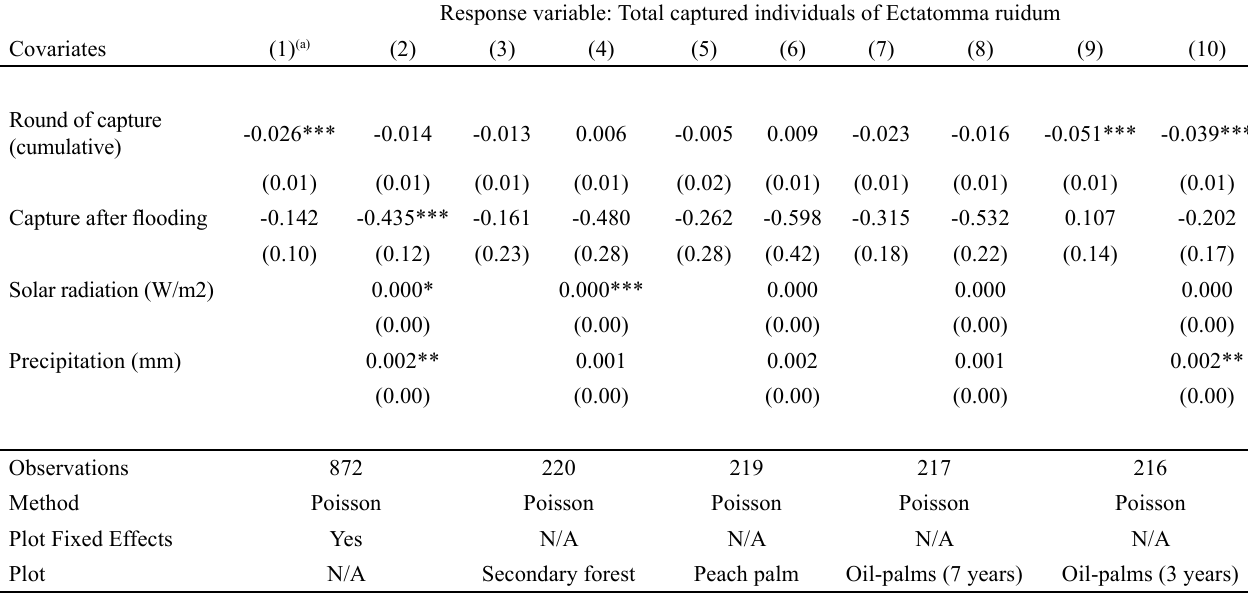
Table 4 . Estimated effect of pitfall trapping over Ectatomma ruidum by Poisson regression model.